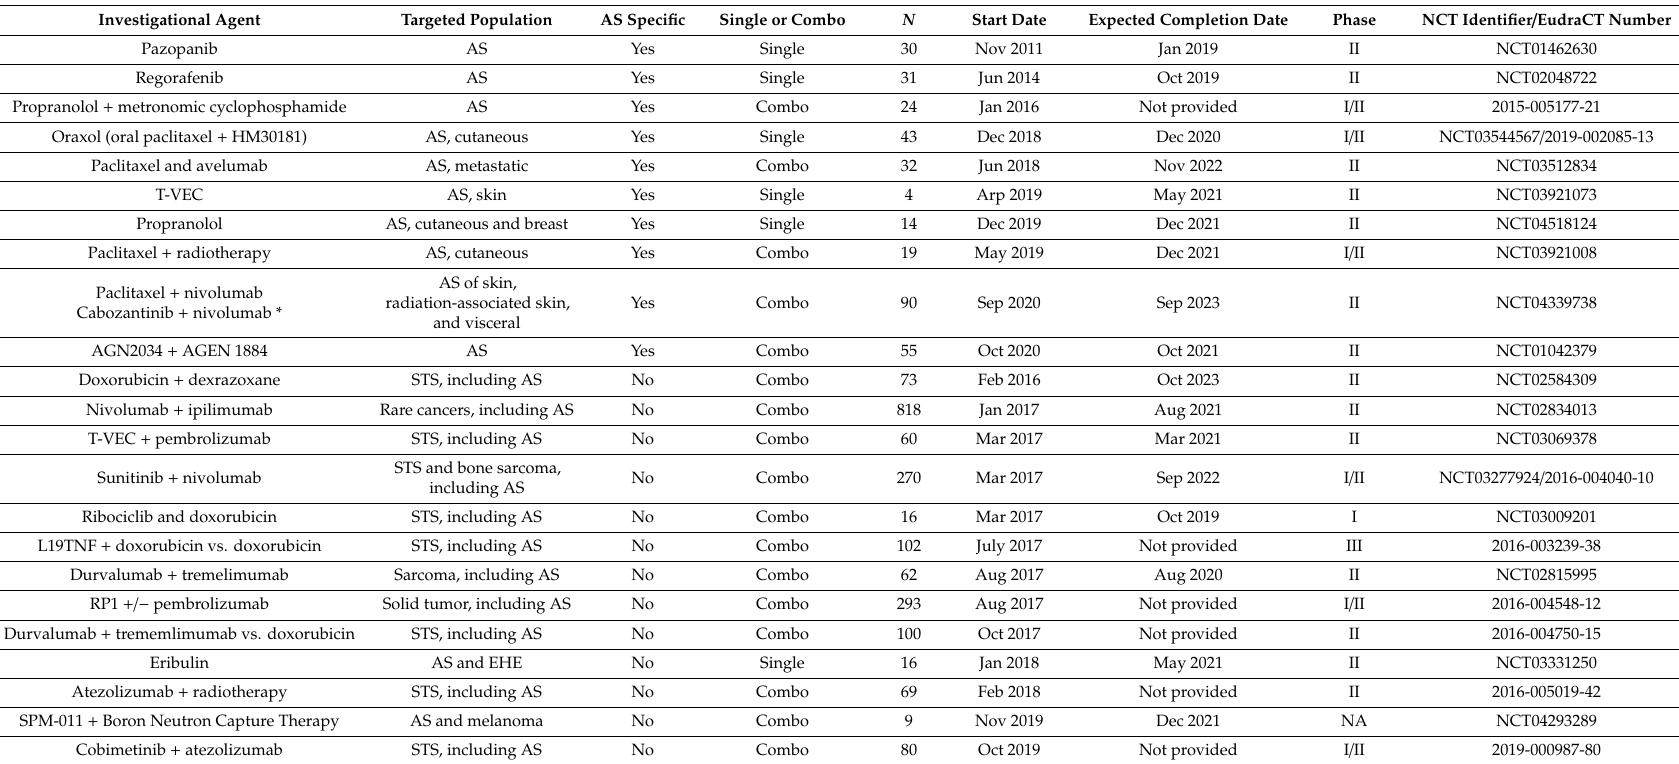
Table 1. Clinical trials investigating systemic treatment activity in